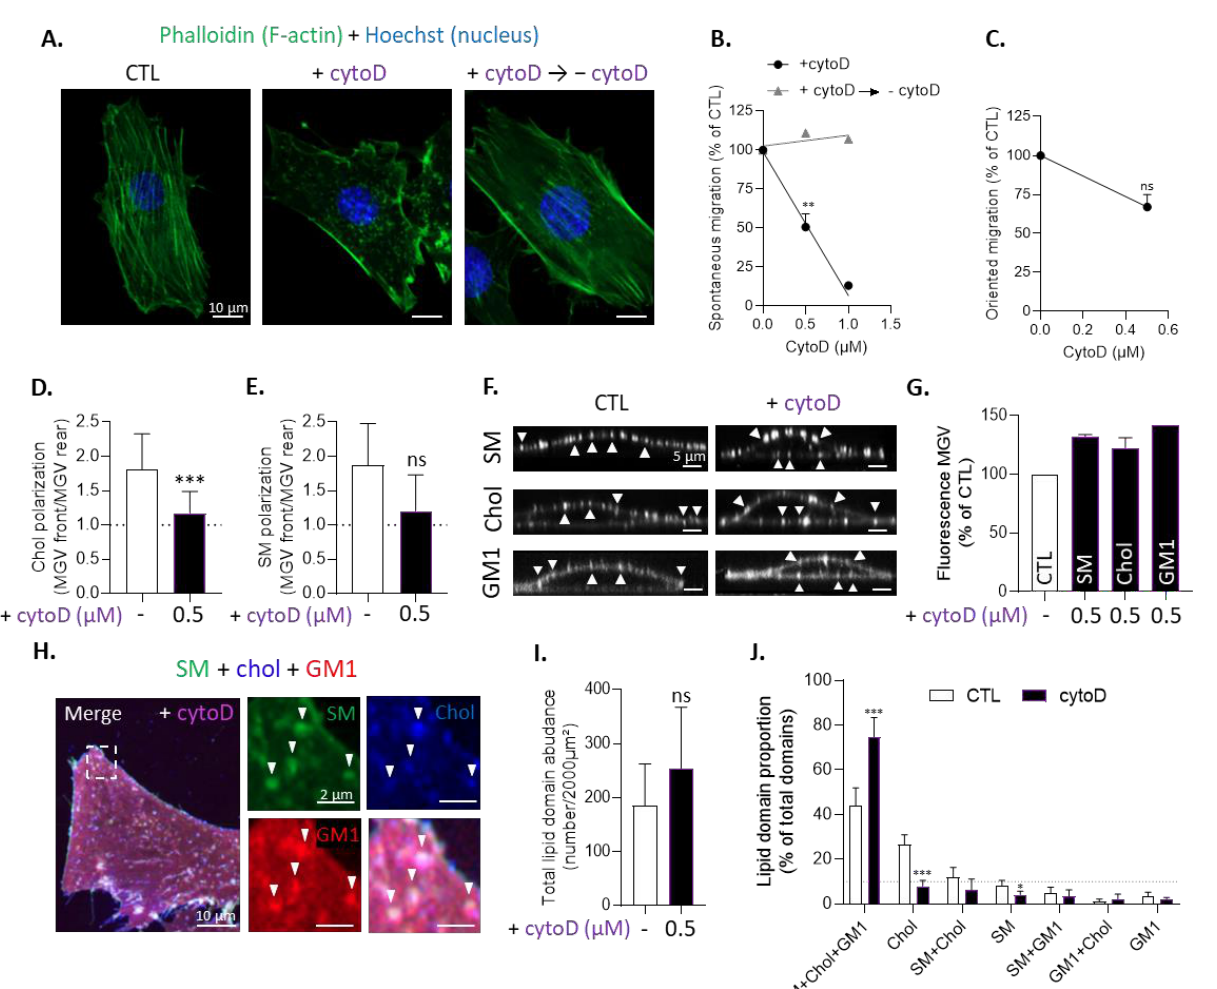
Figure 6. Actin polymerization inhibition by cytochalasin D decreases myoblast migration, cholesterol and sphingomyelin polarization, and chol-enriched domain proportion without depleting membrane lipids. ( A ) Cells were either left untreated (CTL) or pretreated with cytochalasin D (cytoD), then incubated for 5 h in medium still containing cytoD (+cytoD) or in cytoD-free medium (+cytoD -> − cytoD). Cells were then labeled for nucleus (blue) and F-actin (green). ( B , C ) Cells were treated the same way as in A with increasing concentrations of cytoD then migrated in Ibidi chambers ( B ) or transwells towards IGF-1 ( C ). The data are expressed as means ± SD ( n = 1 – 5 independent experiments). Wilcoxon signed-rank test. ( D , E ) The quantification on single-labeled cells of chol (theta, D) and SM (lysenin, E ) polarization after 5 h of migration in control conditions or after pretreatment with cytoD. The data are expressed as the ratio of the MGV at the front vs. the MGV at the rear ( n = 30 – 35 cells from 4 independent experiments). Dotted line indicates no polarization. Unpaired t -test. ( F , G ) Control or cytoD pretreated cells were single-labeled for SM (BODIPY-SM), chol (theta), or GM1 (CTxB), then visualized ( F ) and analyzed for their basal fluorescence MGV ( G ). The data are expressed as means ± SD ( n = 1 – 2 independent experiments). Arrowheads indicate the lipid domains. ( H – J ) Control or cytoD pretreated cells were triple-labeled for SM, chol and GM1 (BODIPY-SM, theta, CTxB), then quantified for lipid domain abundance relative to cell surface ( I ) or proportion ( J ), as in Figure 2. White arrowheads indicate the SM/chol/GM1-enriched domains. Dotted line indicates the threshold for lipid domain acknowledgement. The data are expressed as means ± SD ( n = 6 cells from 1 experiment, 10 – 15 profiles drawn and 150 – 200 domains analyzed/cell). Wilcoxon signed-rank test or two- way ANOVA followed by Sidak’s multiple comparisons test. The statistics above the columns refer to the corresponding control.